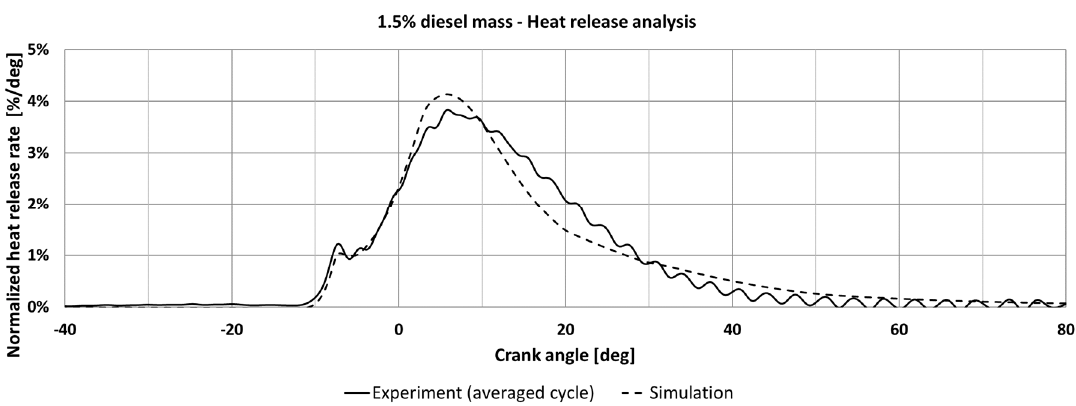
Figure 16. Measured and simulated heat release rates, 1.5% diesel mass injected.